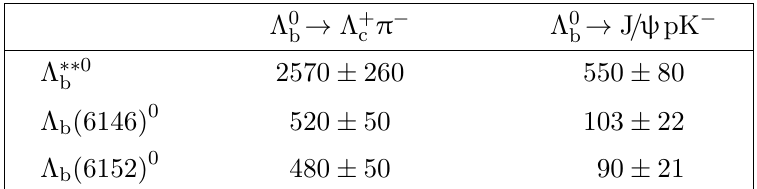
Table 2 . Yields of excited baryons from the simultaneous (cid:12)t to (cid:3) 0 and (cid:3) 0 J = pK (cid:0) b !